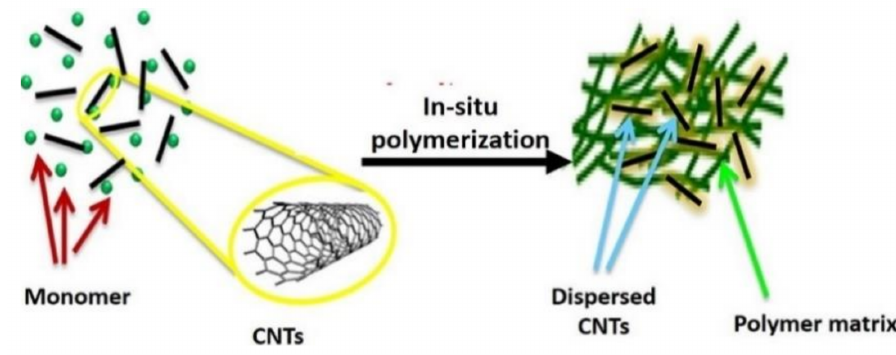
Figure 8. Schematic representation of in situ polymerization process. Reproduced from [90]. Table 2. Summary of advantages and limitations of fabrication techniques for CNT-reinforced polymer composites.